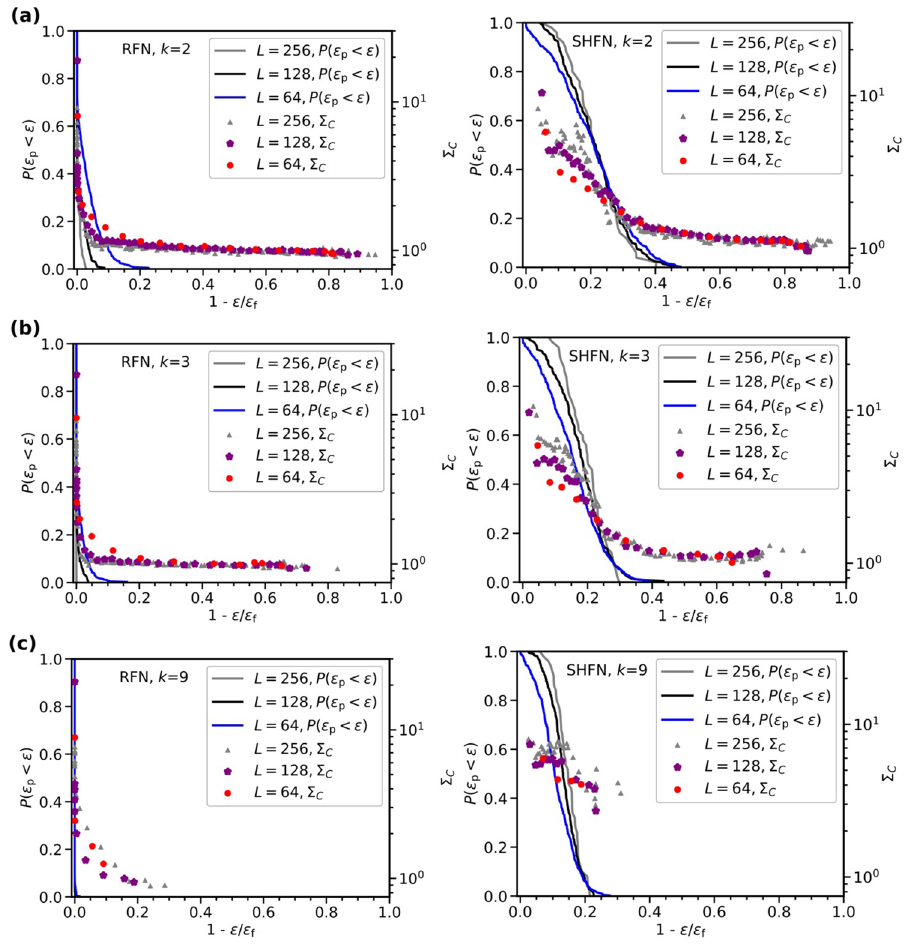
Figure 5. Correlation between GEBC and failure. Solid lines: Fraction of samples beyond the peak stress stage vs. reduced strain-to-failure, for networks of sizes L = 64, 128, 256 ; left: RFN, right: SHFN; thresholds are Weibull distributed with shape factors k = 2 ( a ), k = 3 ( b ) and k = 9 ( c ). Symbols: GEBC mean deviation vs. reduced